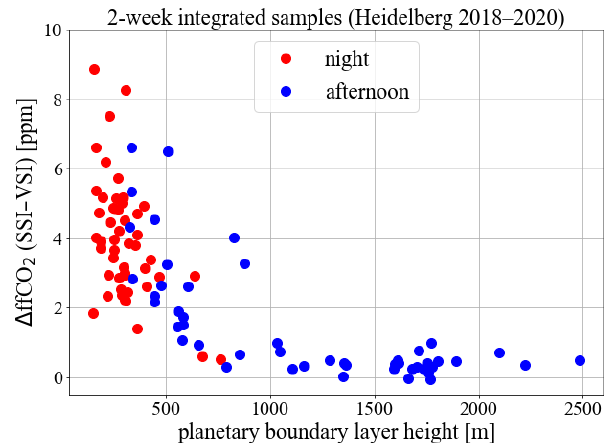
Figure 5. Modelled ffCO 2 differences between the SSI and VSI approaches for Heidelberg afternoon (blue) and nighttime (red) samples plotted against the modelled mean height of the planetary boundary layer (PBL) during sampling.